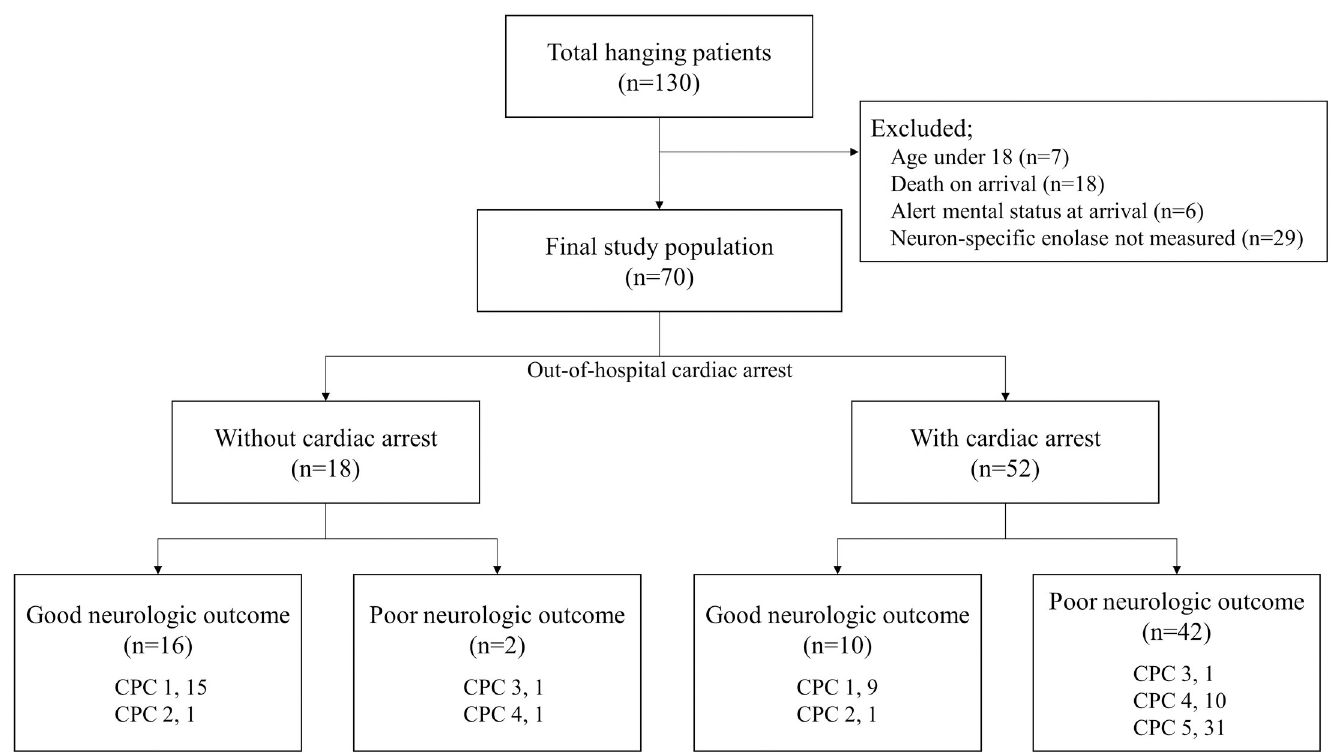
Fig 1. Flow diagram of the study. CPC, Cerebral Performance